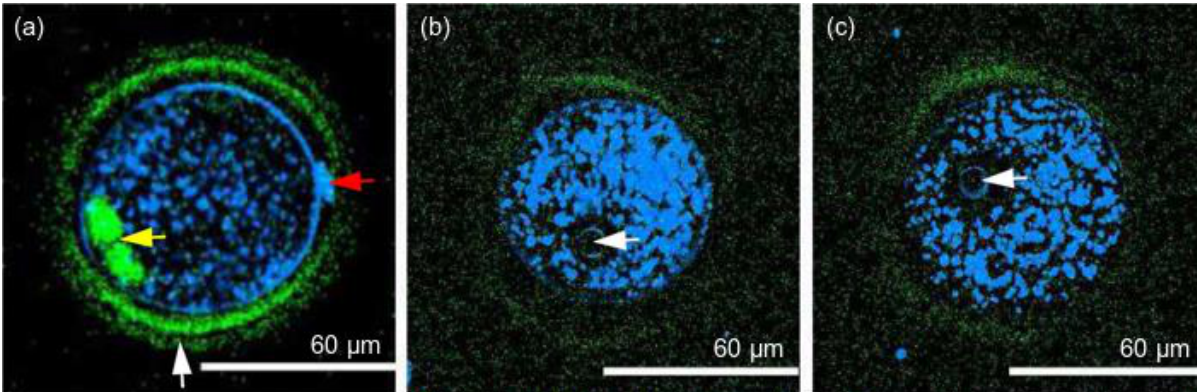
Figure 4. A series of images with combined SHG and THG signals inside the in vitro cultured mouse oocyte: ( a ) the SHG signals reveal the spindle fibers (indicated by the yellow arrow) and the zona pellucida (indicated by the white arrow) of the oocyte, while the THG signals reveal the cell membrane, the organelles, and the polar body (indicated by the red arrow). ( b , c ) are images of the same mouse embryo taken at different depths. The white arrows indicate the two pronuclei. The SHG and THG signals are denoted by green and blue colors, respectively. Adapted with permission from [92] © The Optical Society.